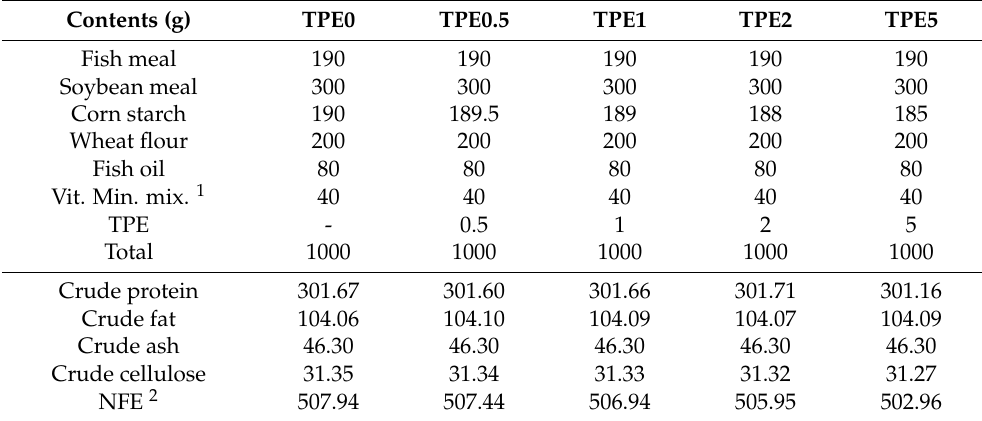
Table 2. Formulation and nutrient content of experimental diets supplemented with different ratios of tomato paste by-product extract